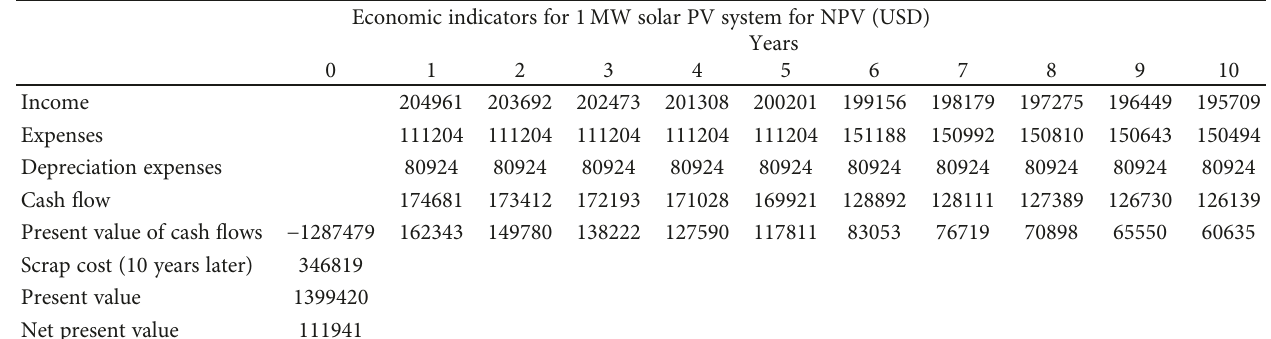
Table 7: Economic indicators for 1 MW solar PV system for NPV.